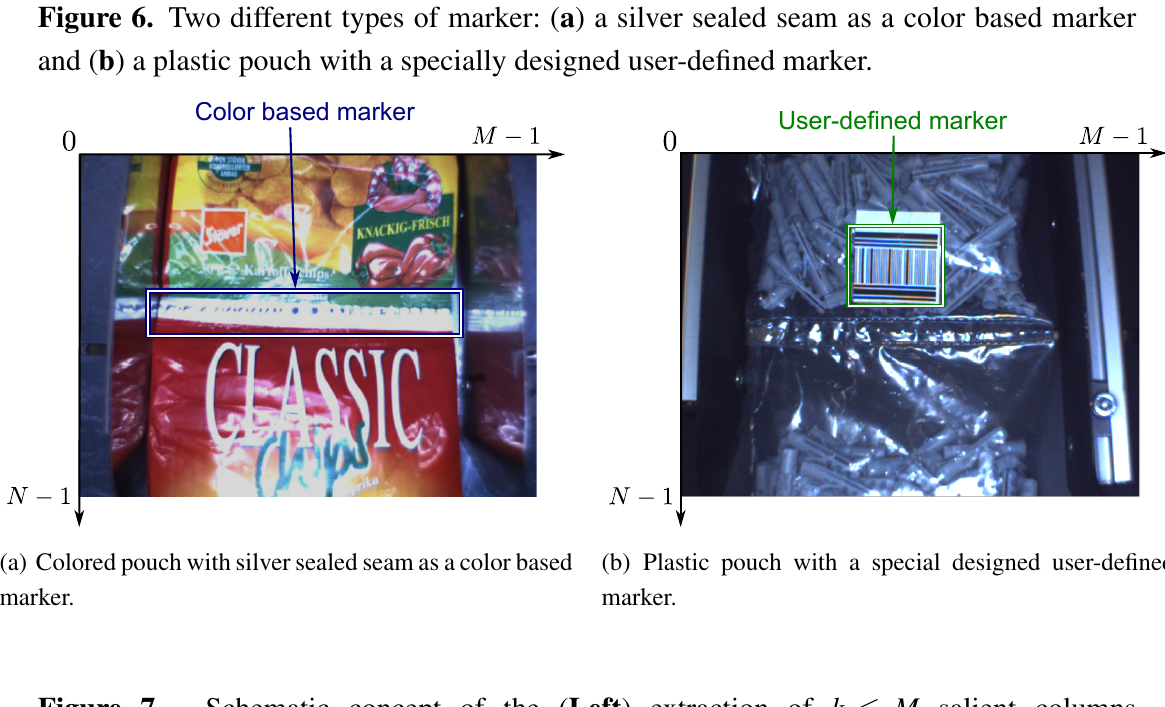
Schematic concept of the ( Left ) extraction of k ≤ M salient columns ρ x ( j ) = { ρ x ( j ) ,..., ρ x ( j ) ,..., ρ x ( j ) } from an image of size N × M pixels–the RGB-channel i N − 1 0 is represented by ρ ∈ { r , g , b } . The salient columns undergo a classification process leading to a time series which assigns the image rows a specific probability of containing the marker ( Right